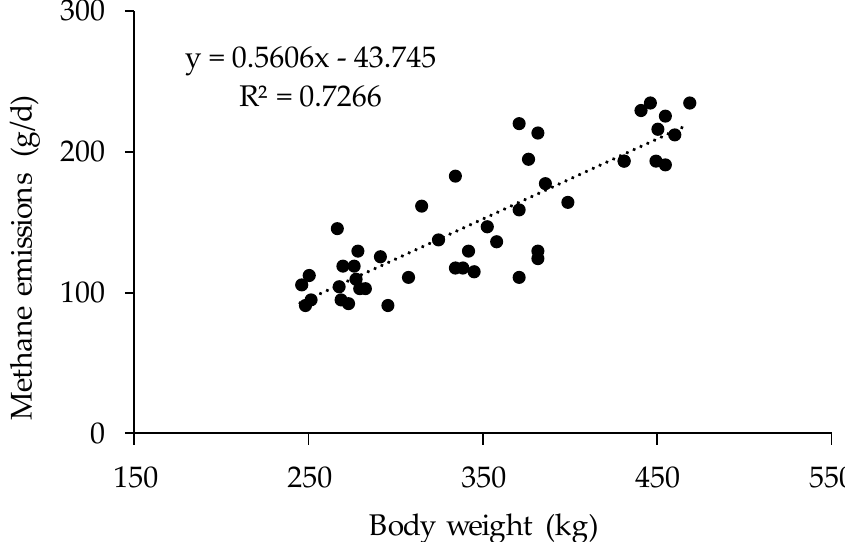
Animals 2018 , 8 , x FOR PEER REVIEW Figure 1. Linear relationship between body weight and enteric methane emissions of Holstein heifers.